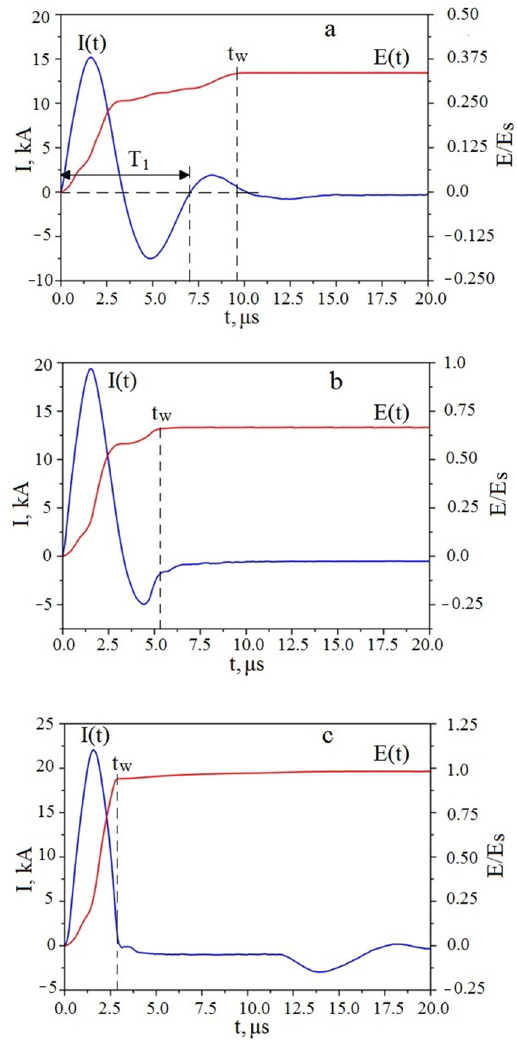
Figure 3. Temporal oscillogram curves of current I(t) and energy E(t) for electrical explosion of aluminum wires: ( a ) Sample 1, ( b ) Sample 2, ( c ) Sample 3.